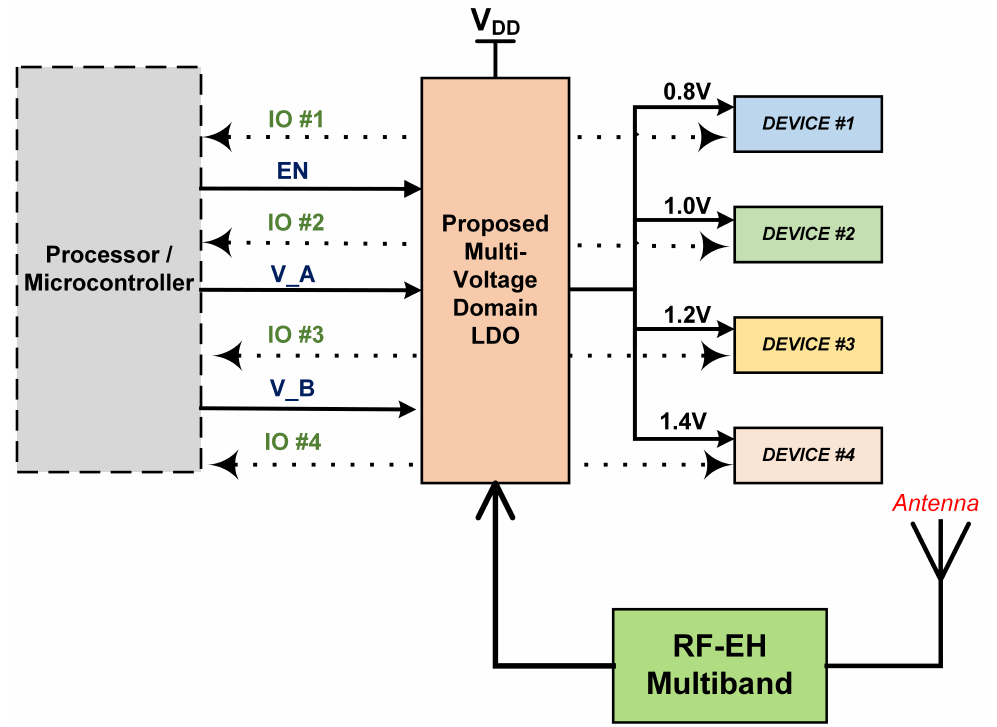
Figure 1. Block diagram of MVD-LDO for RFEH-based IoT